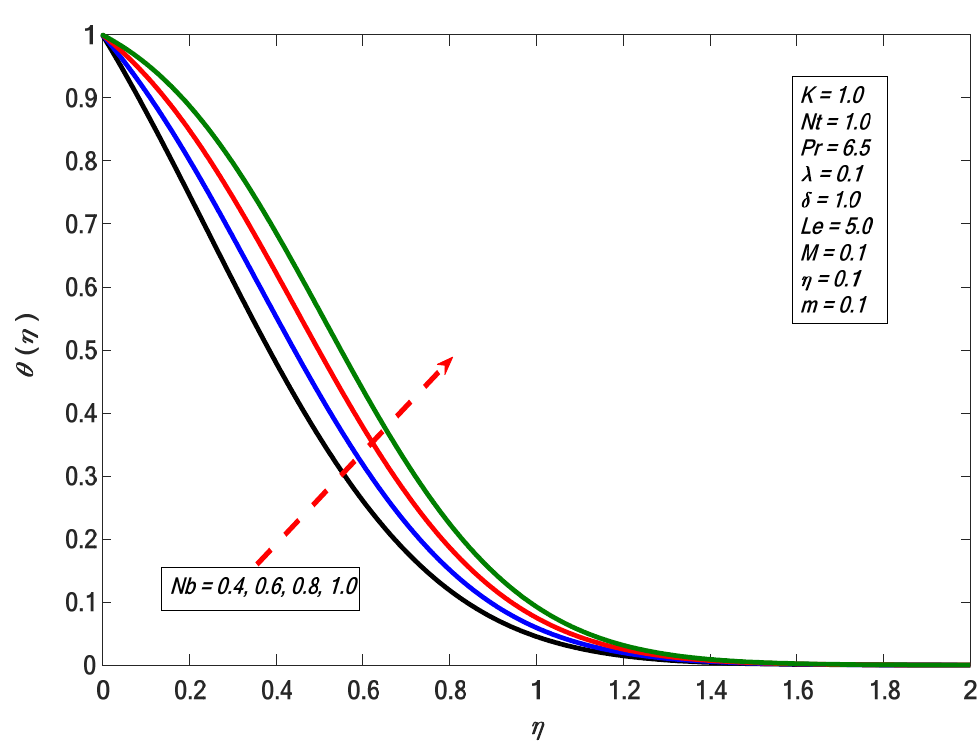
Figure 5. h ( η ) for various values of K . Figure 5. h (cid:4666)𝜂(cid:4667) for various values of 𝐾.